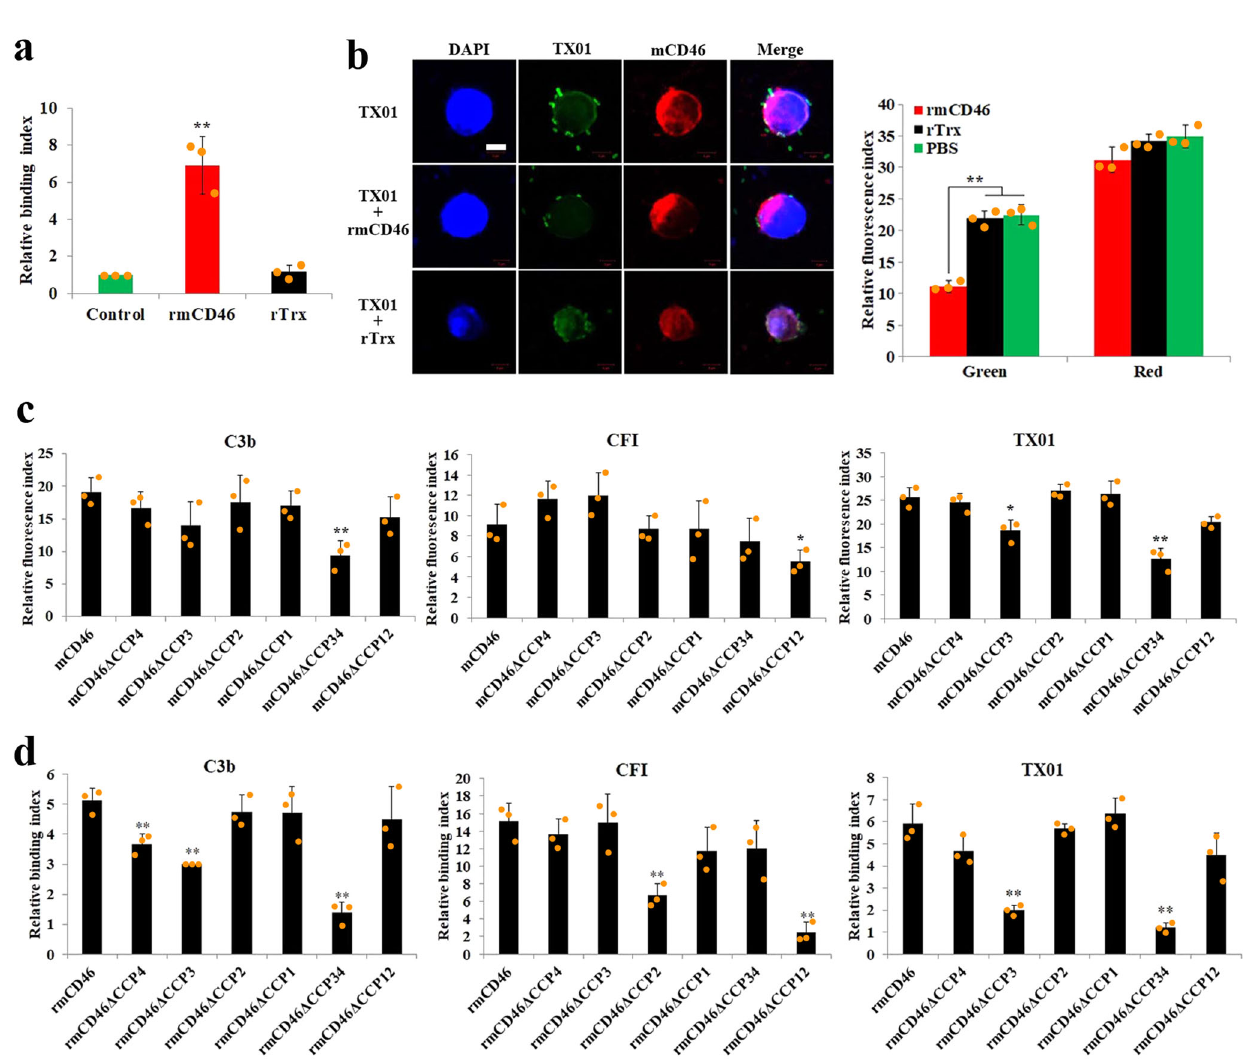
Fig. 6 Binding of rmCD46 to Edwardsiella tarda and its dependence on the conserved CCP domains. a E. tarda TX01 was incubated with or without (control) rmCD46 or rTrx, and the bacteria-bound protein was determined by ELISA. b TX01 was pre-incubated with or without rmCD46 or rTrx. The bacteria were then used to infect HEK293T cells expressing Flag-tagged mCD46. After infection, the cells were treated with Alexa 594-labeled antibody targeting Flag-tagged mCD46 and FITC-labeled antibody targeting TX01. The cells were then stained with DAPI and subjected to microscopy or measurement of green and red fl uorescence. Bar, 5 μ m. c HEK293T cells expressing Flag-tagged mCD46 or its mutants were incubated with or without C3b, CFI, or TX01 for 1 h. The cells were treated with FITC-labeled antibody targeting C3b, CFI, or TX01, and then measured for fl uorescence. d rmCD46 and its mutants were incubated with or without C3b, CFI, or TX01, and the binding was determined by ELISA. In all panels, the data are the means of three independent experiments and presented as means ± SEM. In panels c, d, statistical signi fi cance was determined by comparing with mCD46/rmCD46. ** P < 0.01; * P <